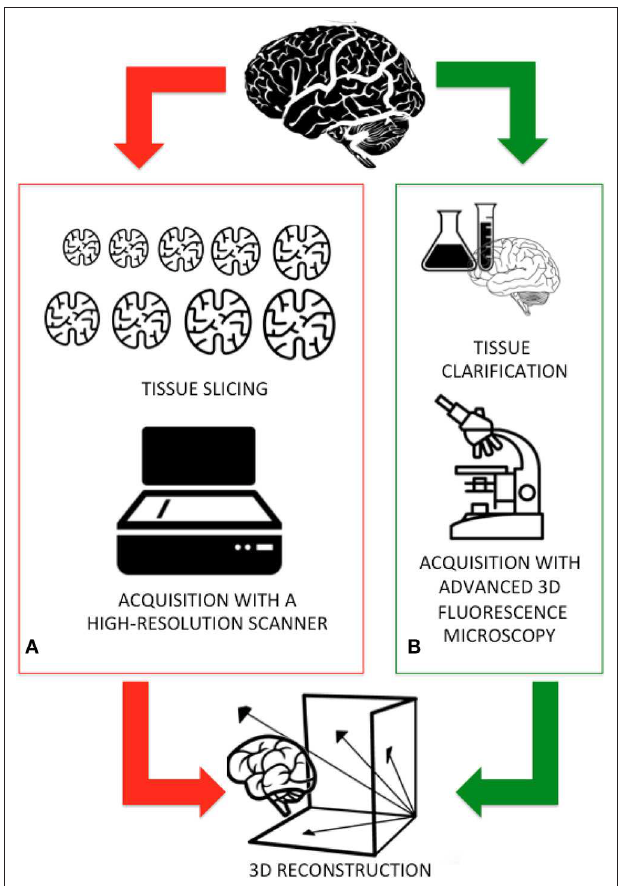
FIGURE 1 | (A) The traditional workflow adopted for digitizing an entire brain: the sample is first fixed in formaldehyde and embedded in paraffin and then cut in thin slices. Subsequent slices are collected, acquired using a high-resolution scanner, and finally aligned and reconstructed. (B) A new workflow, integrating new methods for processing the samples and advanced 3D imaging will be faster and more accurately deliver the reconstruction of an entire mammal